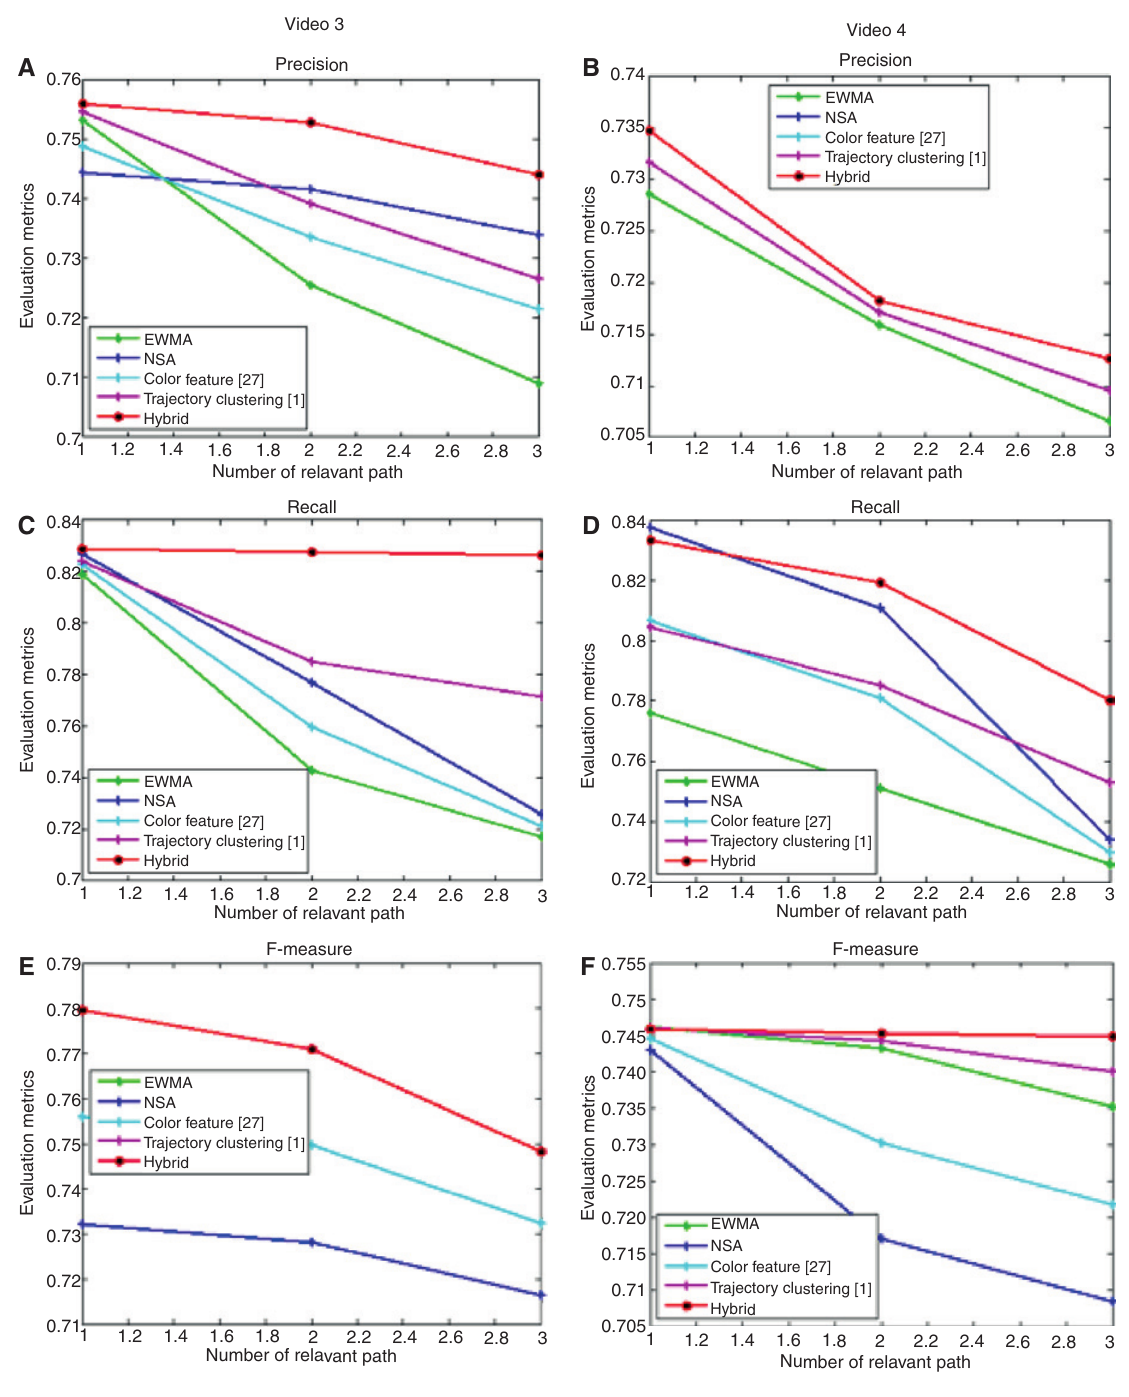
Figure 9: Performance Analysis of Video Object Retrieval for Video 3 and Video 4. (A) Video 3-Precision, (B) Video 4-Precision, (C) Video 3-Recall, (D) Video 4-Recall, (E) Video 3-F-measure and (F) Video